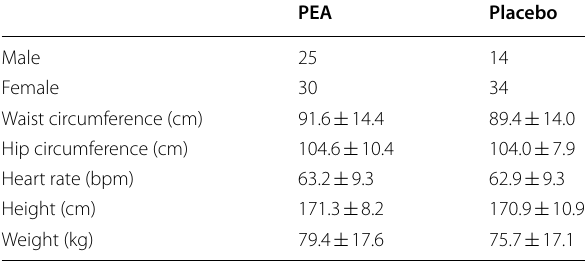
standard deviation; PEA ±